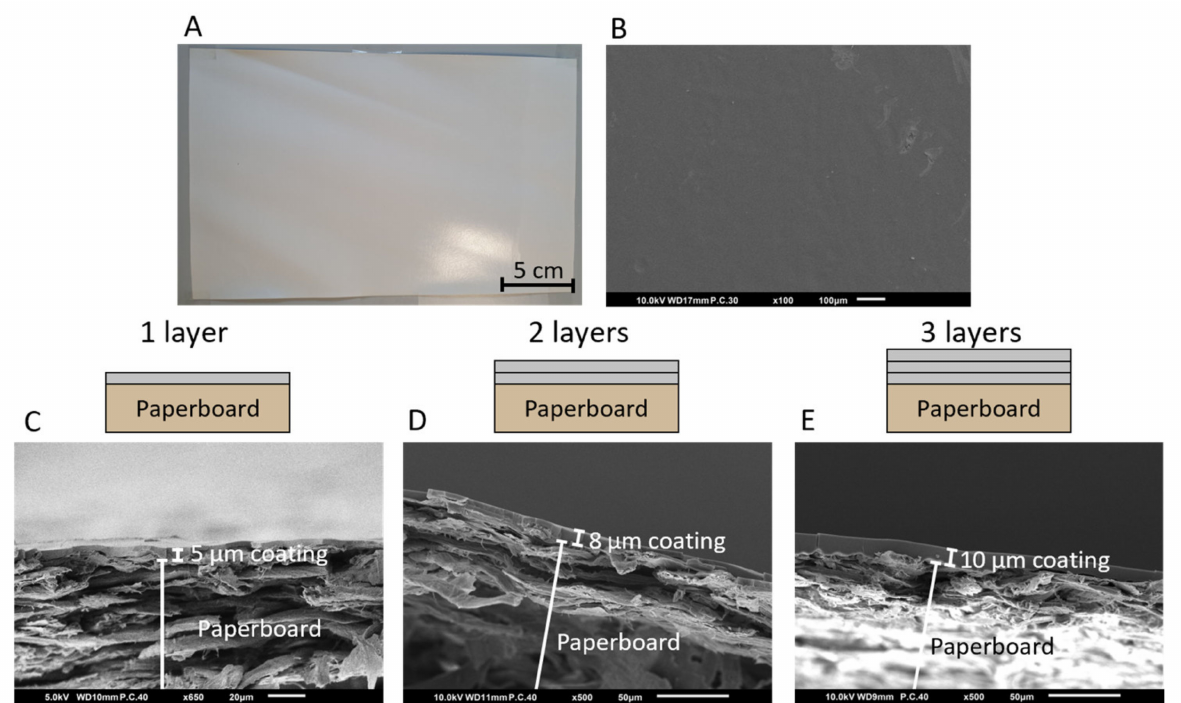
Figure 1. ( A ) SEM image and ( B ) photograph of the surface of the triple-layer coating on paperboard. SEM images of the cross-section of coated paperboard with corresponding coating thickness of ( C ) one, ( D ) two and ( E ) three coating layers. The waterborne coatings are obtained by applying an ASR-stabilized dispersion containing 5 wt% isopropanol on